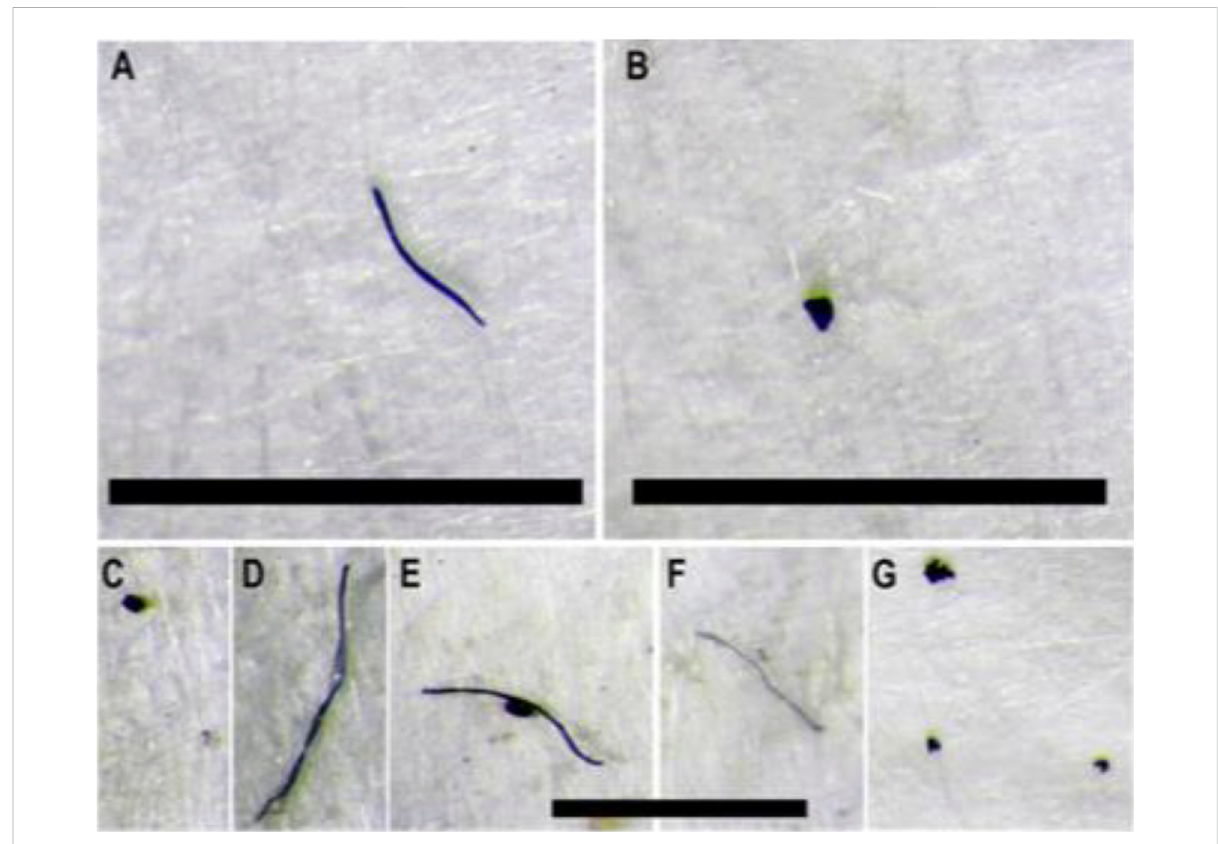
FIGURE 3 Microplastics found in fi sh stomachs from the Mississippi River. Fiber (A) and fragment (B) found within Shortnose Gar. Fibers and fragments (C – G) are fi bers and fragments found within in Largemouth Bass. All black bars represent 1 mm